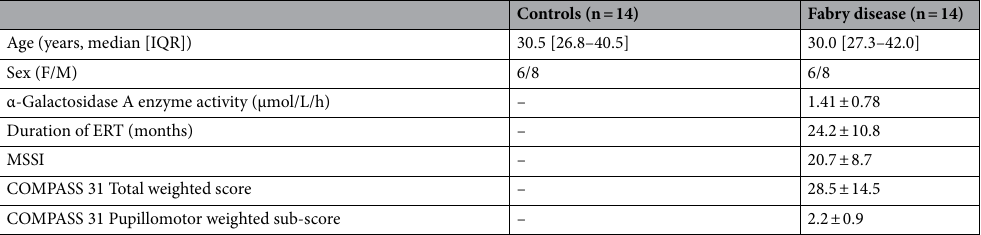
Table 1. Baseline characteristics. Data are expressed as mean ± SD for parametric variables and median [IQR] for non-parametric variables. COMPASS Composite Autonomic Symptom Scale, ERT enzyme replacement therapy, MSSI Mainz Severity Score Index.